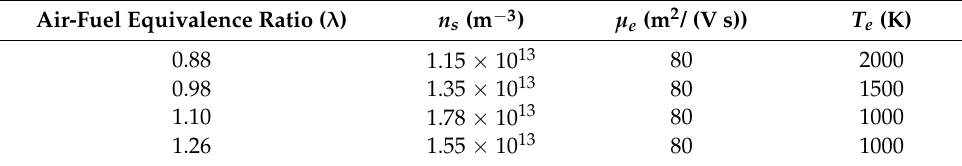
Figure 10. I-V characteristics obtained with the turbine spark plug and the laboratory test burner for different air to fuel equivalent ratios λ , as per legend. Dots: experimental data; solid lines: model fitting. Table 2. Assessed model parameters for data reported in Figure